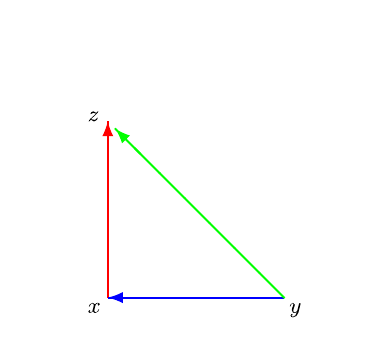
Figure 1: The edge - colored digraphs G and H ,